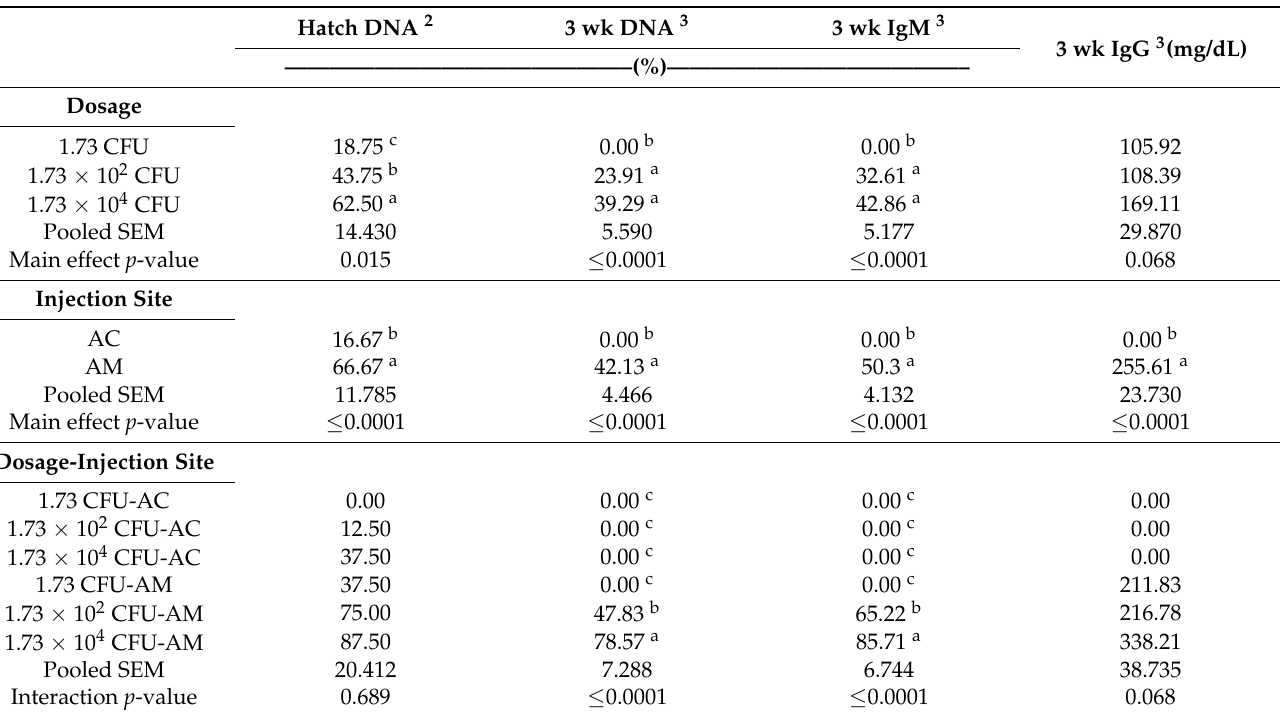
Table 10. Main and interaction means for percentage of birds that tested positive for MG DNA in the choanal cleft at 22 days ( d ) of incubation ( doi ) ( Hatch DNA ) and at 3 wk posthatch ( 3 wk DNA ) and IgM ( 3 wk IgM ) and IgG ( 3 wk IgG ) serologic responses in the serum at 3 wk posthatch 1 due to 6/85 MG dosage and site of injection (air cell ( AC ) or amnion ( AM )). Hatch DNA